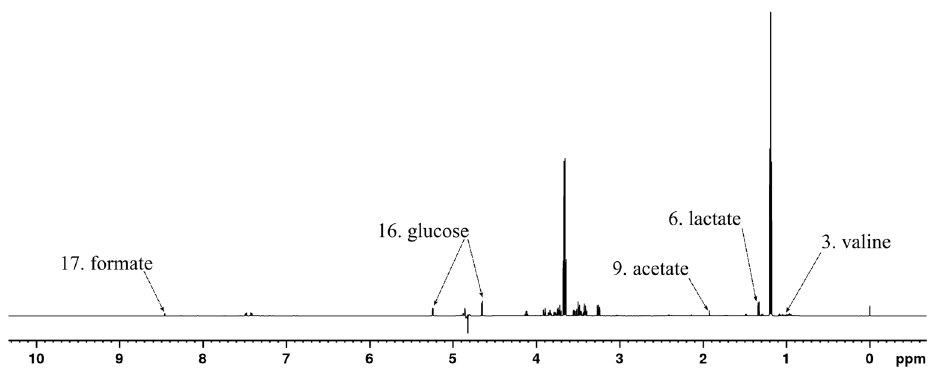
Figure 6. 1 H NMR spectrum of S. aureus culture sample at the 0 h time point after treatment with rugosin D ( 6 ) with example signals of the significant metabolites labeled according to Table 1.